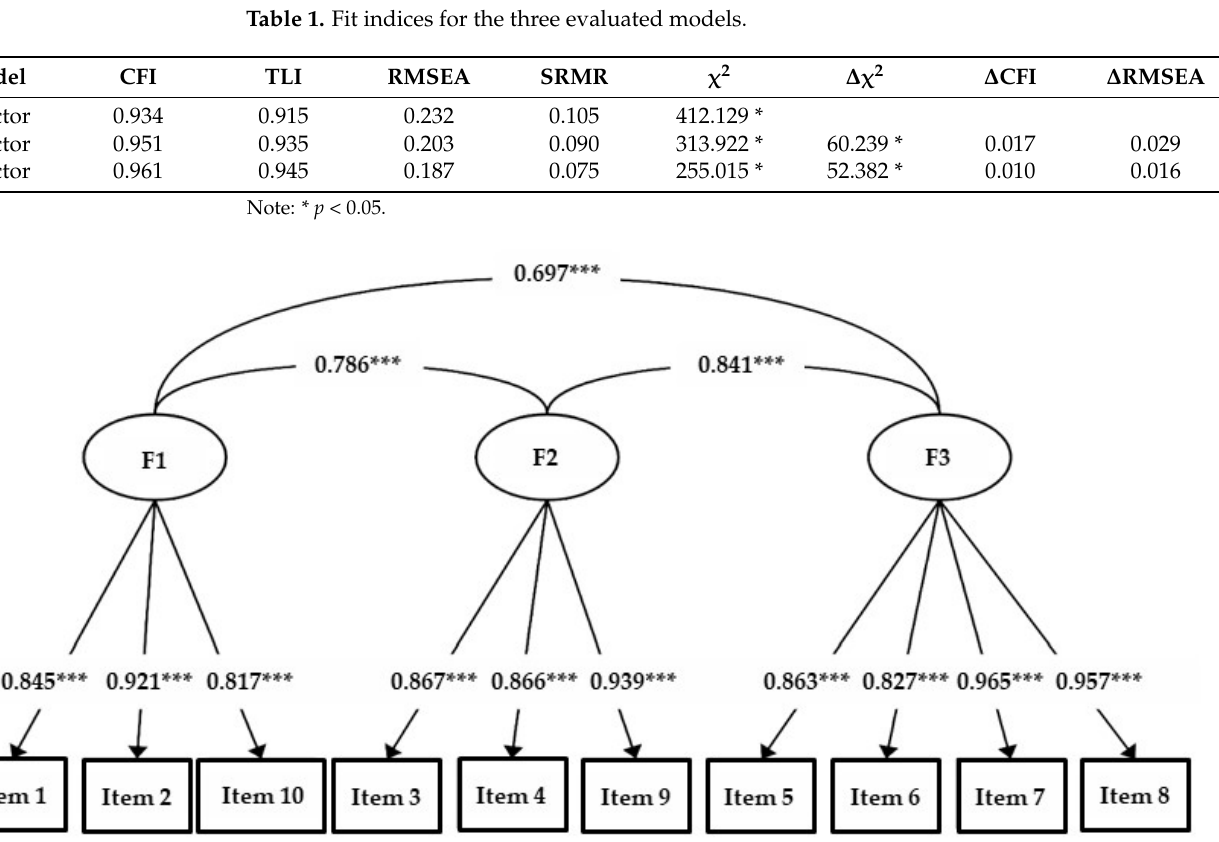
Figure 2. Three-factor model of HPSQ Thai version . Note . *** p < 0.001